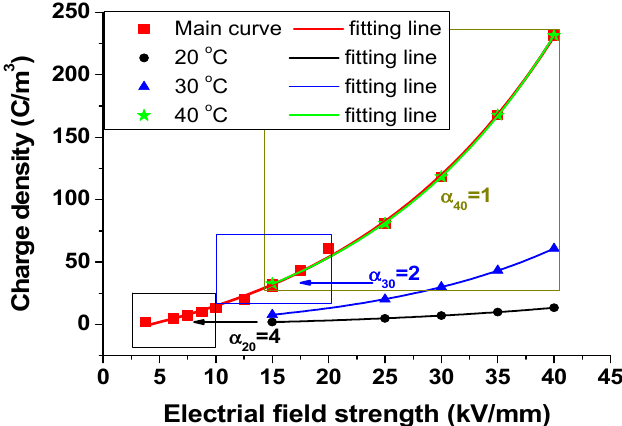
Figure 12. Interface charge density absolute values at steady state under different electrical field strengths with different temperatures.